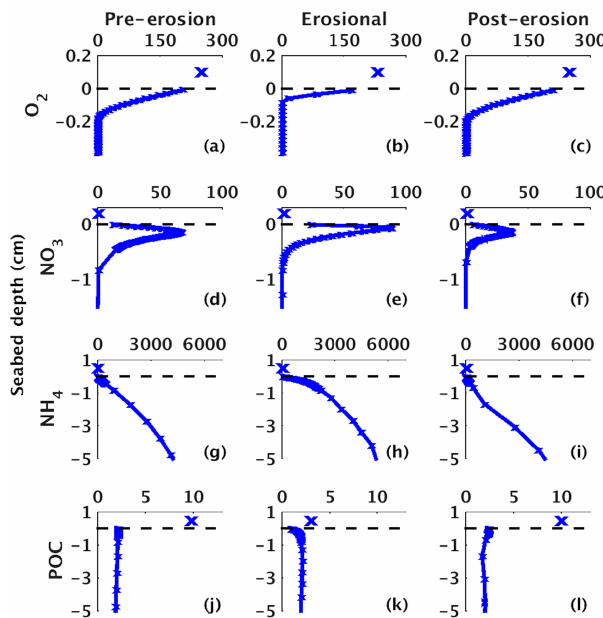
Figure 5. Seabed profiles of oxygen (top row; mmol O 2 m − 3 ) , nitrate (second row; mmol Nm − 3 ) , ammonium (third row;mmol N m − 3 ) , and degradable particulate organic carbon (POC; bottom row; dry weight (%)) from the standard model run for times imme- diately preceding the mid-April resuspension event (6 April 2012, left column), during the erosional period (10 April 2012, center col- umn), and during the depositional period (13 April 2012, right col- umn). Figure 4 shows the times at which the profiles were estimated. Tick marks on the blue lines indicate the location of each seabed layer. The black dashed lines indicate the seabed–water interface, and all seabed depths are given relative to this interface. The “ x ”s indicate near-bed values for the water